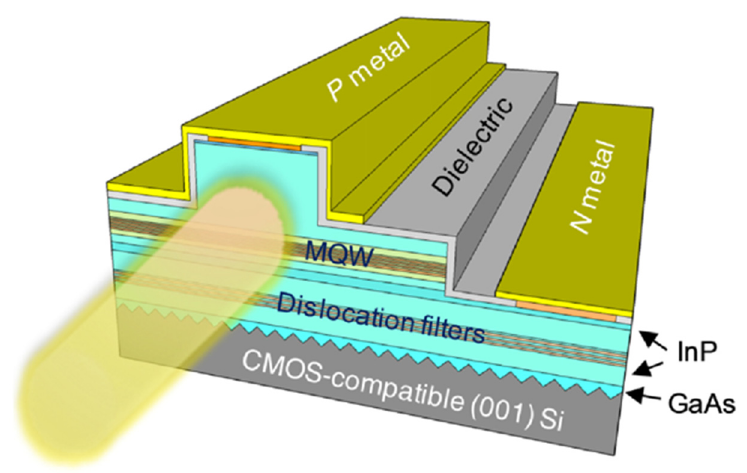
Figure 16. Schematic representation of an InP-based laser on (001) Si. Reprinted with permission from ref. [74] © The Optical Society. Copyright 2019 Optica.